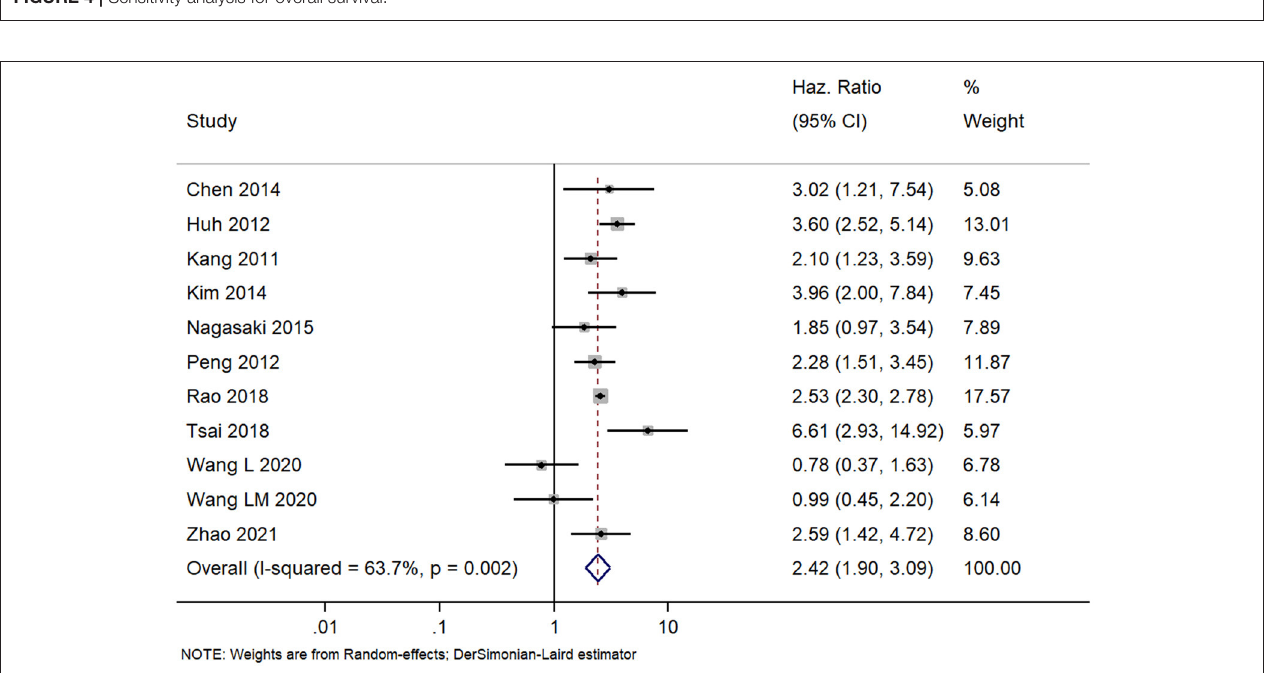
FIGURE 5 | Forest plot showing the difference in disease-free survival between the APN-positive and -negative patient cohorts (data from 11 studies).